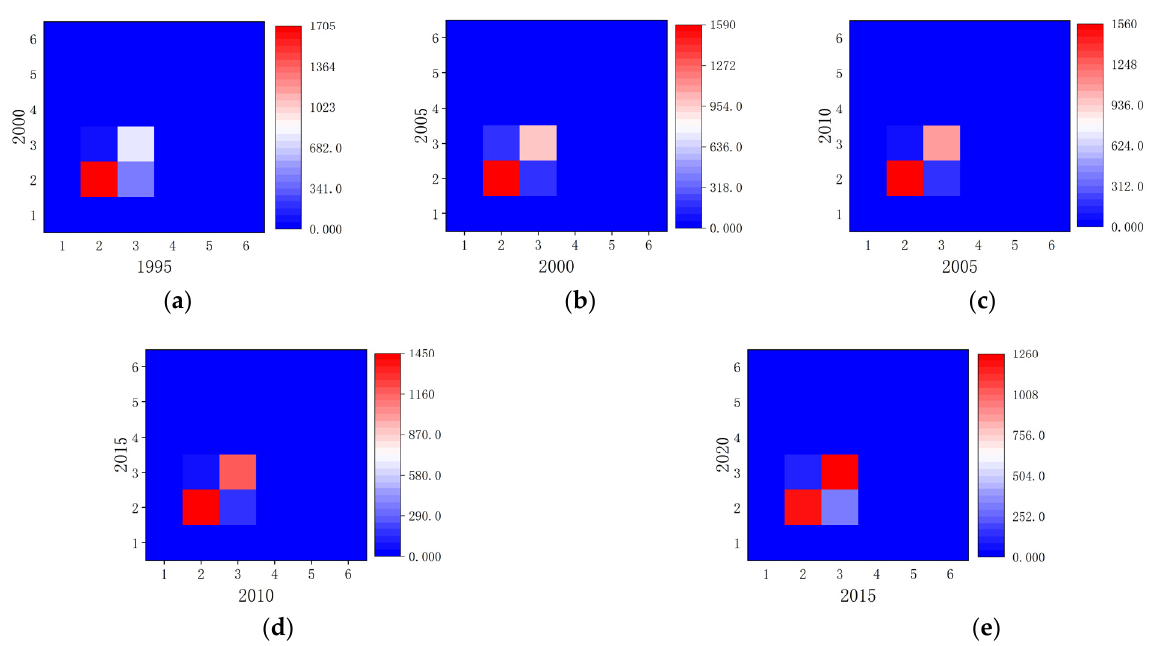
Figure 5. Heat maps of the transition matrices of the Changbai Mountains from 1995 to 2020 (unit: km 2 ): ( a ) from 1995 to 2000, ( b ) from 2000 to 2005, ( c ) from 2005 to 2010, ( d ) from 2010 to 2015, and ( e ) from 2015 to 2020.